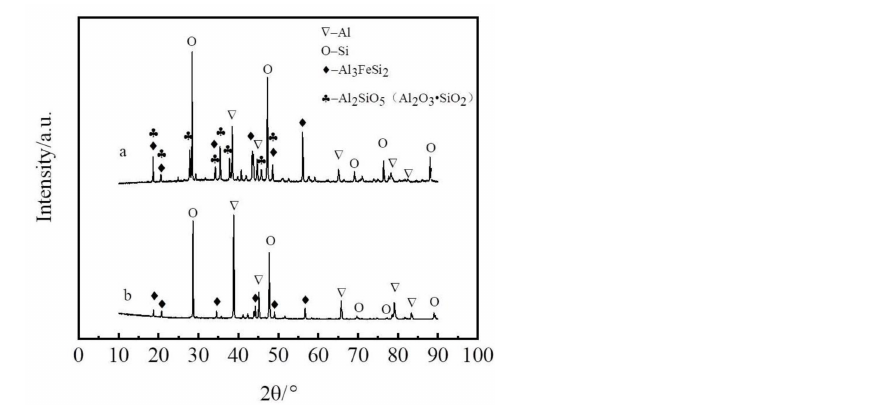
Figure 1. XRD of spectra of coarse Al–Si alloy. ( a ) before; ( b ) after the refining. Table 1. Composition of the coarse Al–Si alloy (wt%).